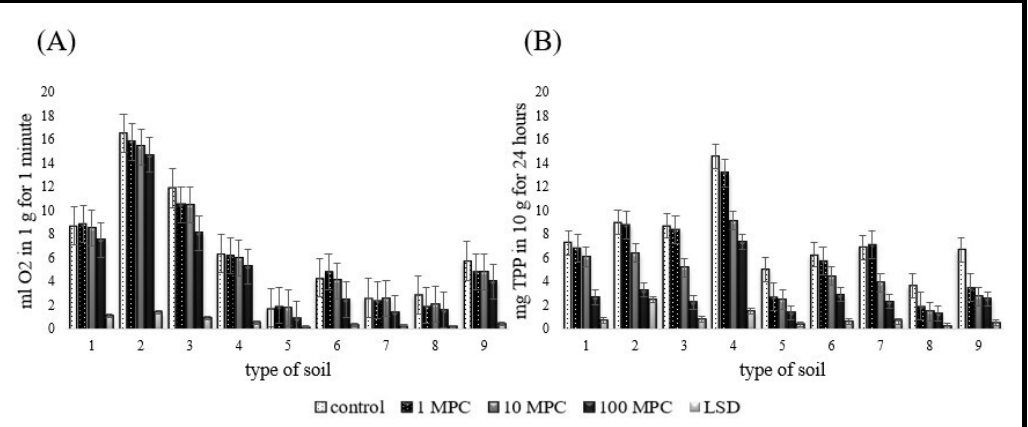
Figure 3. Changes in the catalase ( A ) and dehydrogenases ( B ) activity of the forest soils: 1, brown leached soil; 2, brown typical soil; 3, brown carbonate soil; 4, yellow soil; 5, acid brown forest soil; 6, sod-carbonate typical soil; 7, leached sod-carbonate soil; 8, acid brown forest podzolized soil; and 9, brown forest slightly unsaturated soils.